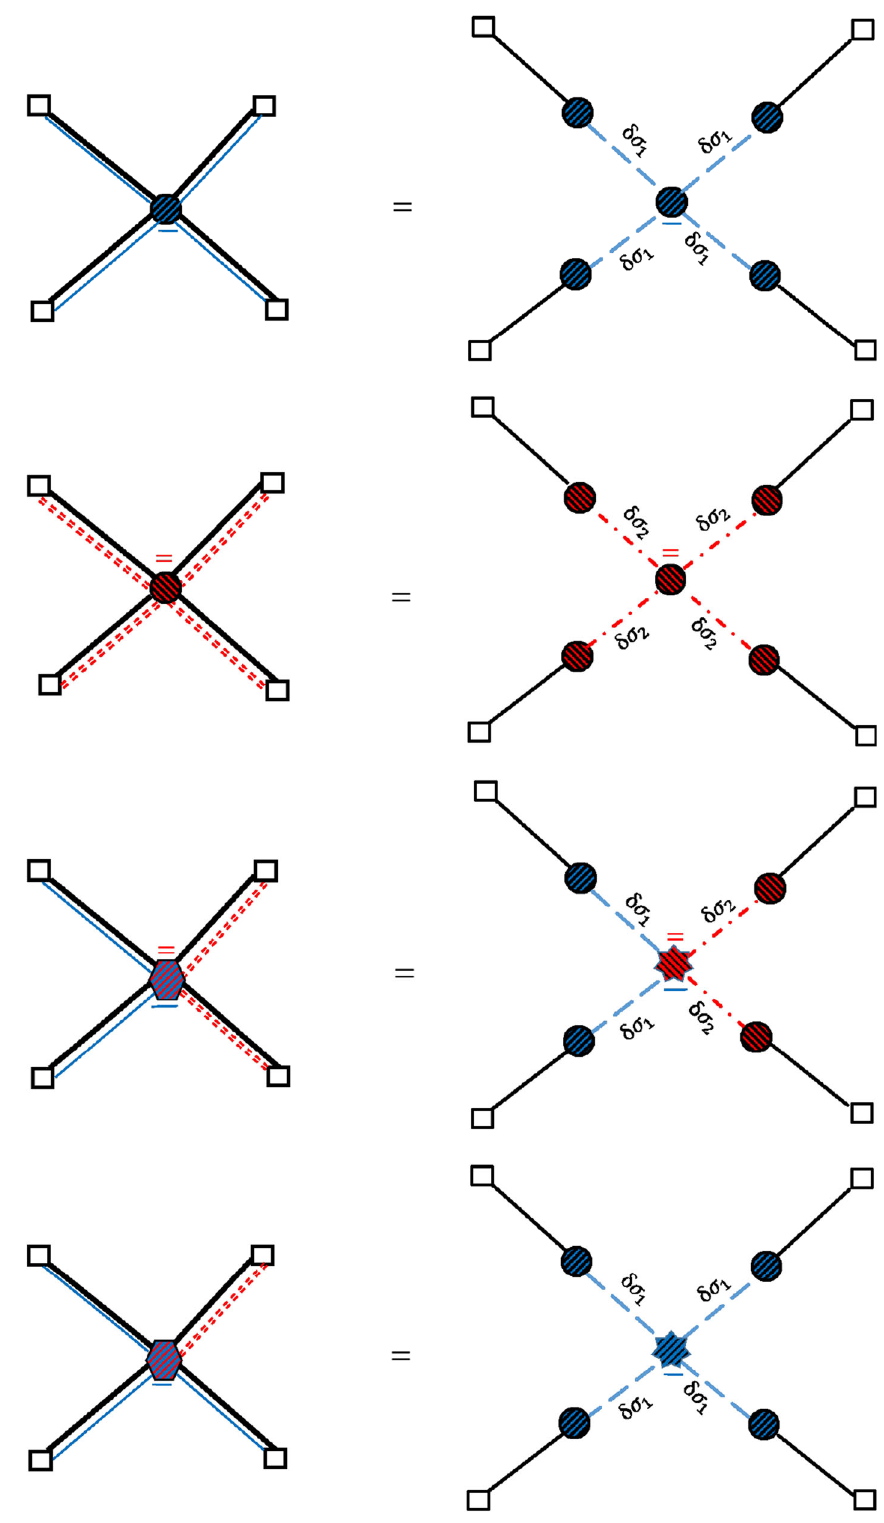
Fig. 18 This diagram shows the self interaction for quasi-massive field δσ 1 . The order of interacting for such a diagram is expressed as